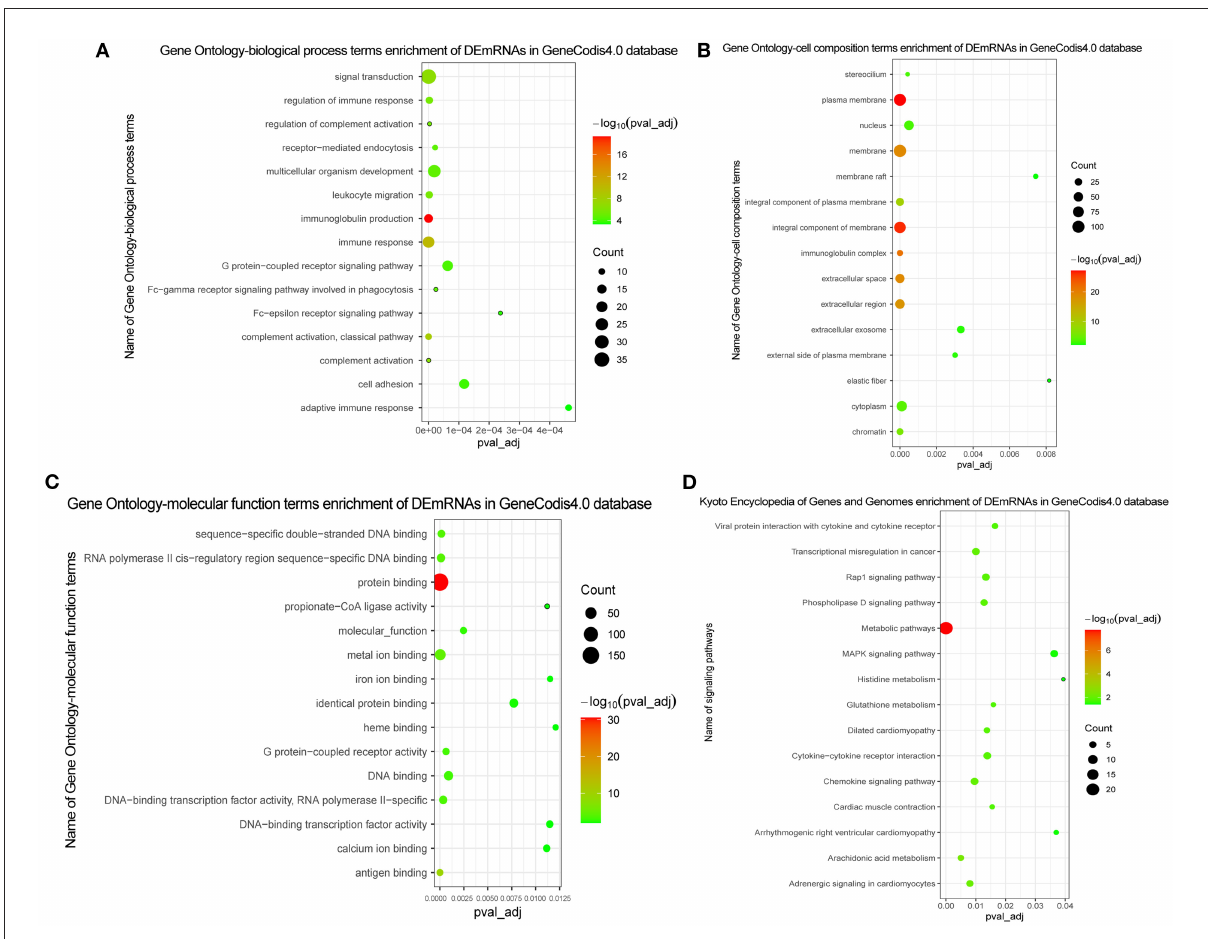
FIGURE2 GO and KEGG functional enrichment of DEmRNAs. (A) In GO function enrichment analysis, top 15 significantly enriched biological process of DEmRNAs; (B) In GO function enrichment analysis, top 15 significantly enriched cell composition of DEmRNAs; (C) In GO function enrichment analysis, top 15 significantly enriched molecular function of DEmRNAs; (D) In KEGG function enrichment analysis, top 15 significantly enriched signaling pathways of DEmRNAs. The bubble on the graph represents the size of the pval_adj, the redder the more significant. The screening criteria were pval_adj <